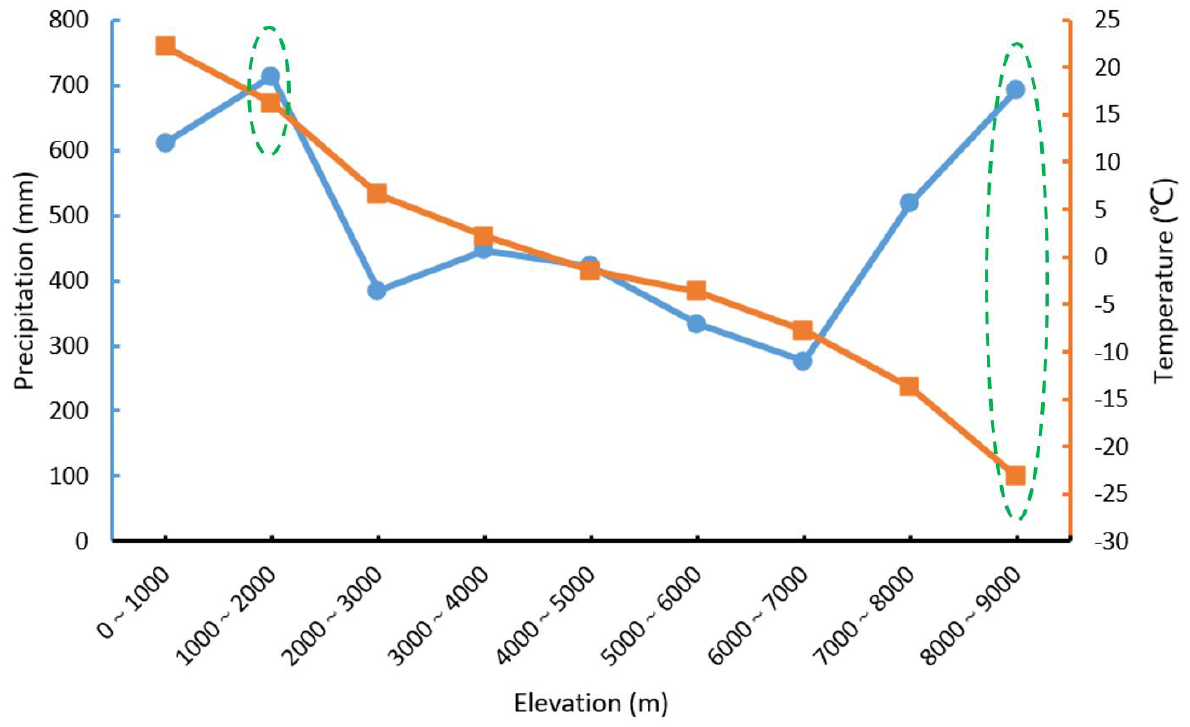
Figure 11. Changes of precipitation and temperature at different elevations.